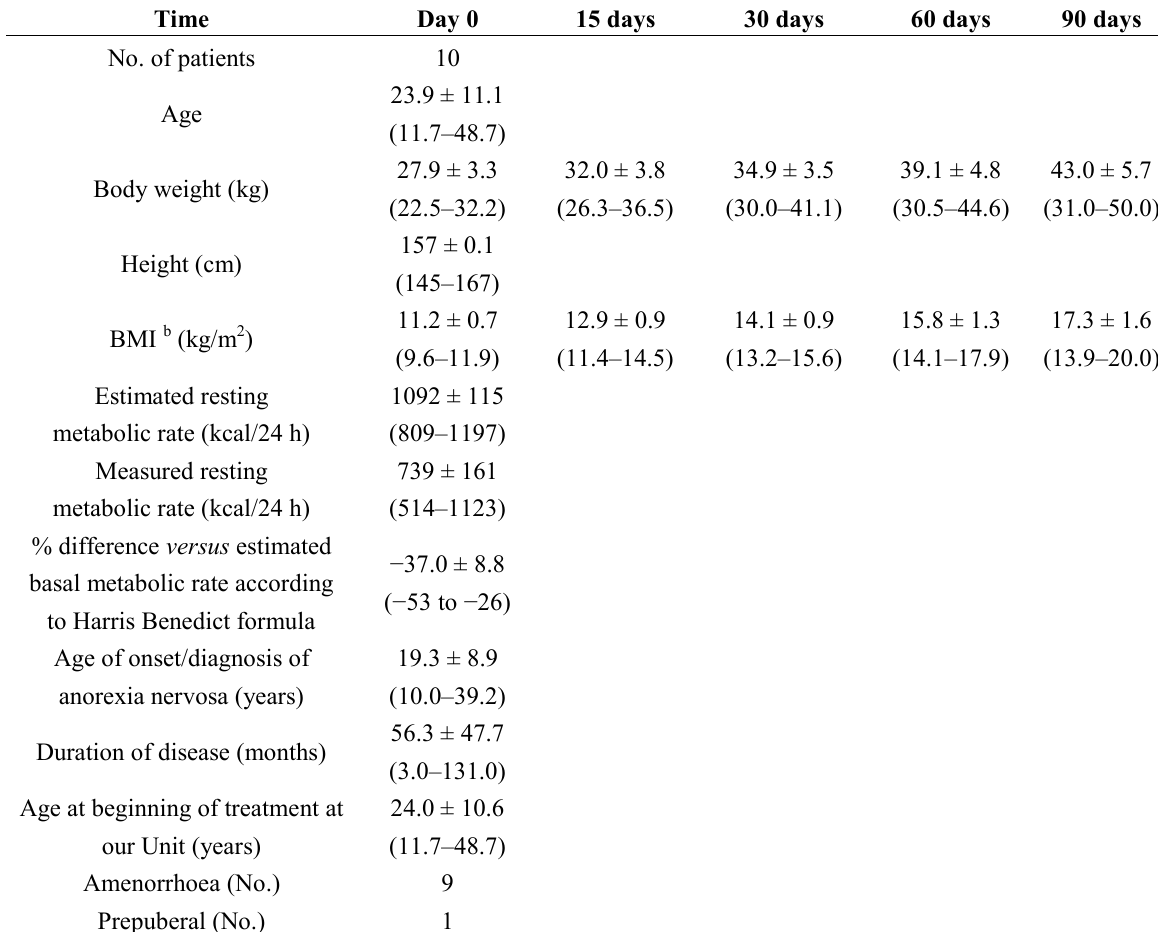
Table 1. Antropometric demographic and clinical data in 10 anorexia nervosa patients with extreme undernutrition a .